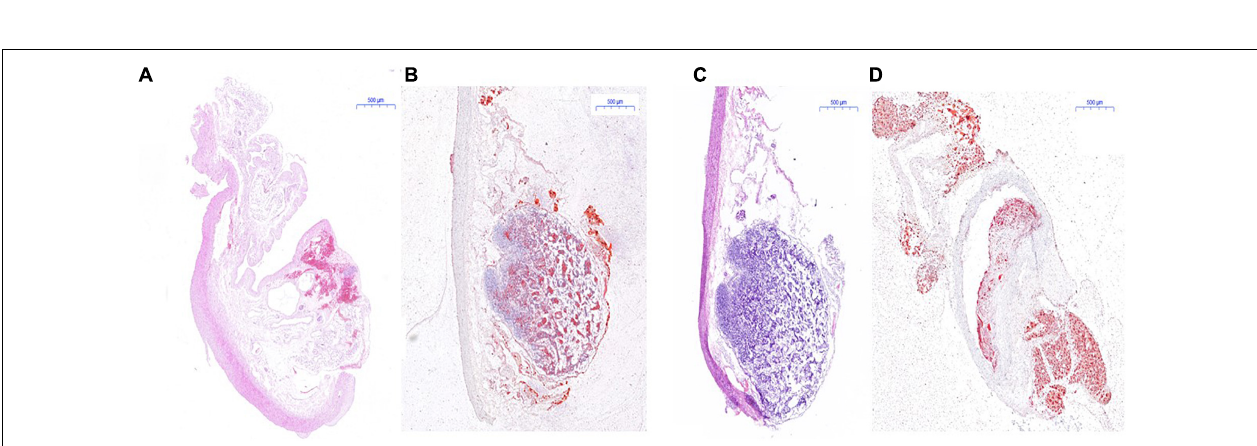
FIGURE 7 | Biological distribution rate of mice between ApoE – / – mice and mice in the control group.